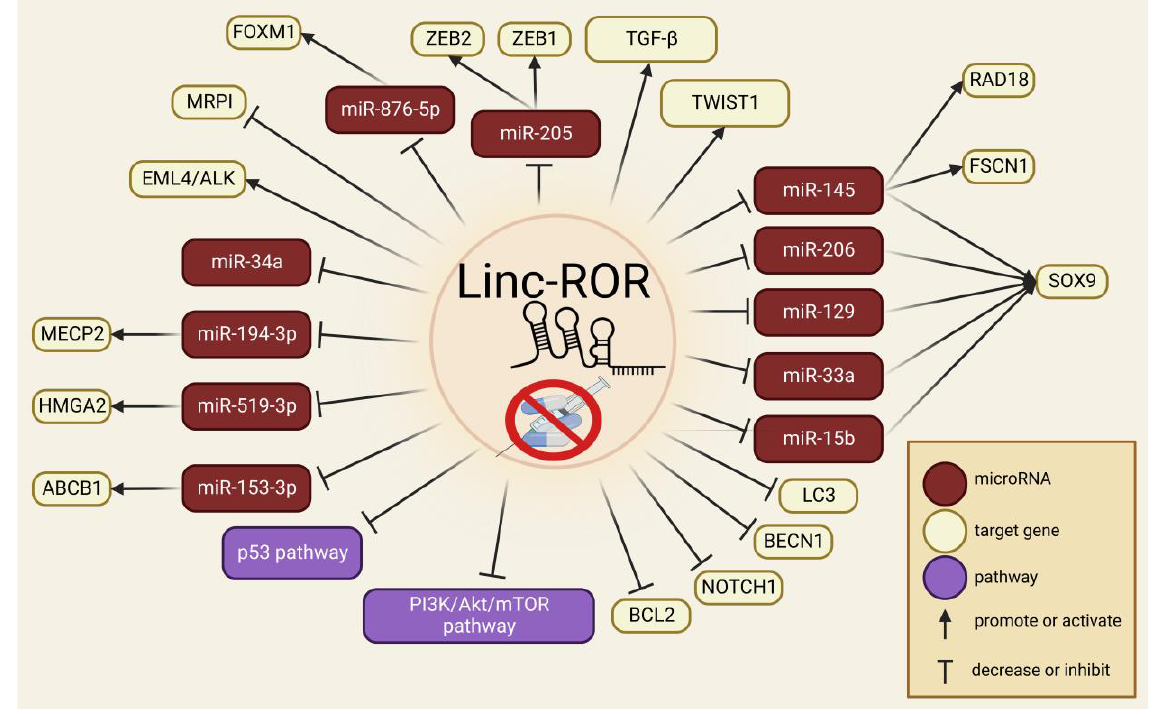
Figure 3. Overview of the molecular mechanisms by which linc-ROR participates in cancer drug resistance. drug